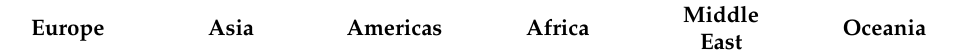
Table A1. List of member states and associate members that have designated seafarers as key workers.